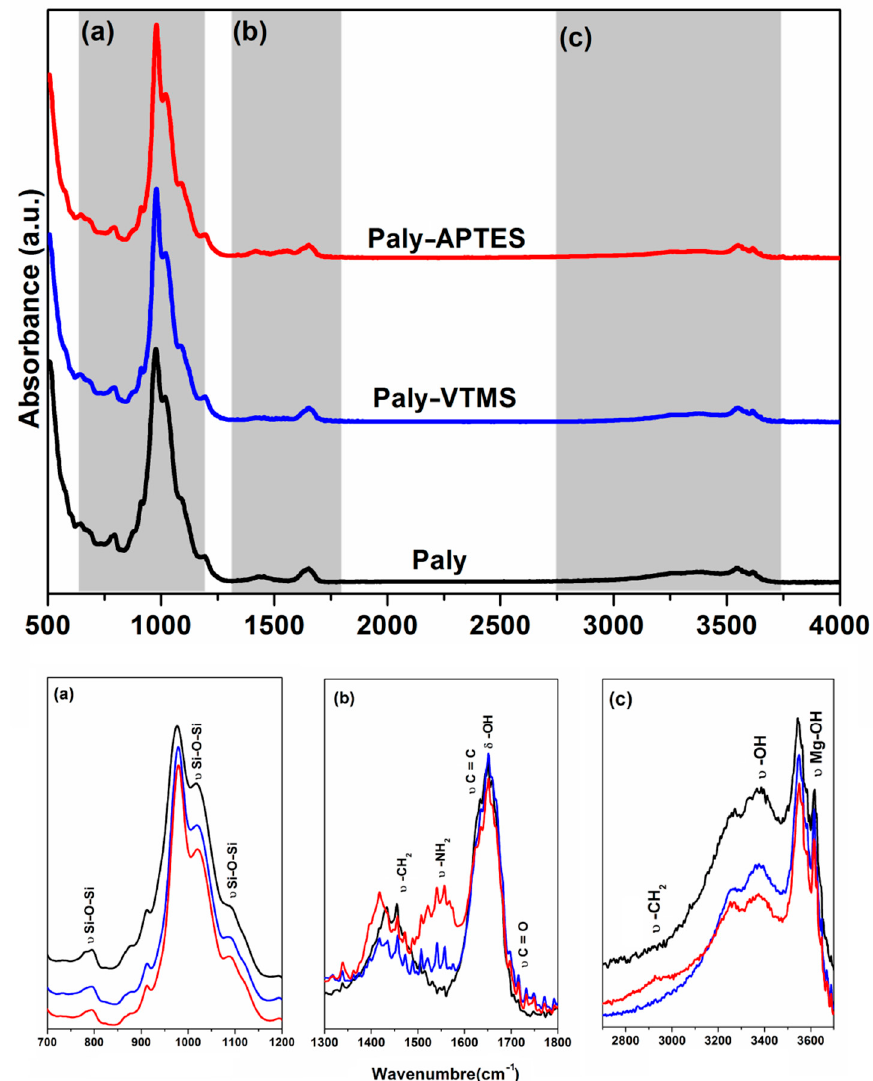
Figure 2. Fourier transform infrared (FTIR) spectra of Paly, Paly-APTES, and Paly-VTES for wavenumber (cm − 1 ) ranges: ( a ) 700–1200; ( b ) 1300–1800; and ( c ) 2700–3700.